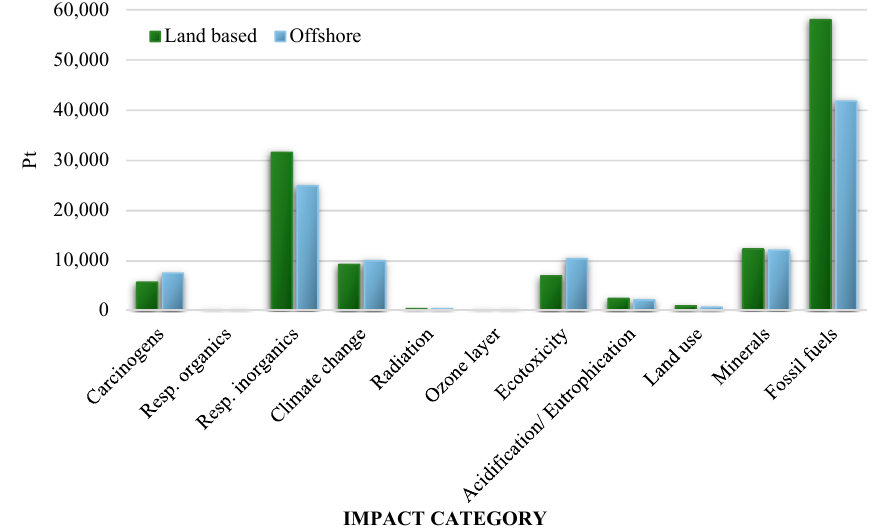
Figure 7. Results of grouping and weighing the environmental effects for the type of impact caused by operation of land and offshore wind power plant cycles. Authors’ own